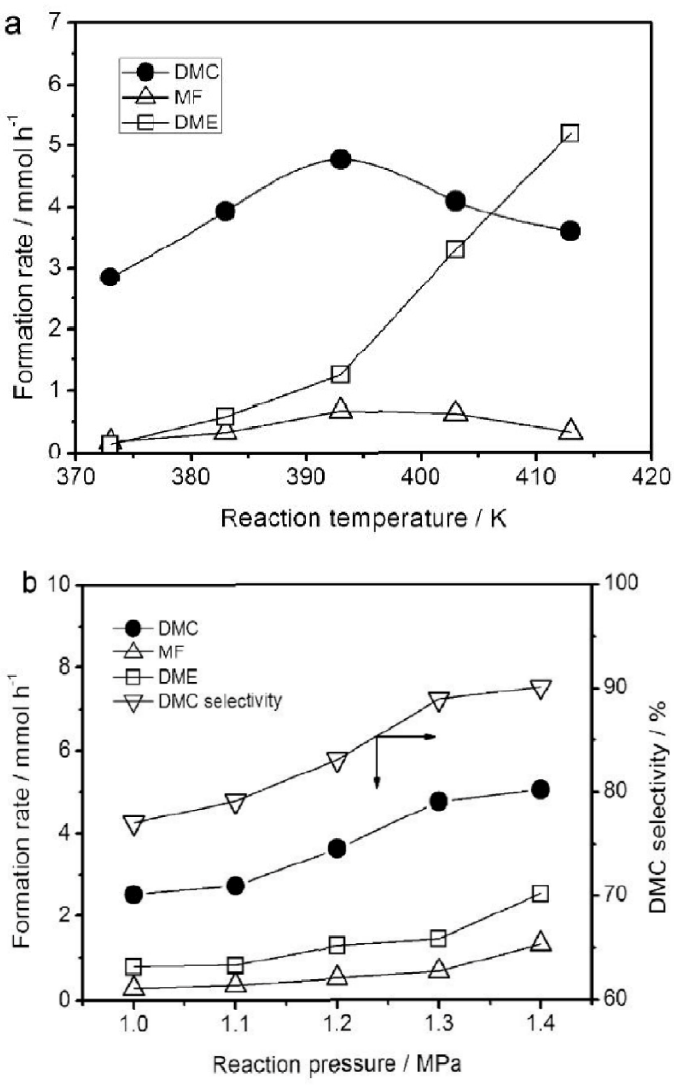
Figure 2. Effects of ( a ) reaction temperature and ( b ) pressure (at 393 K) on the DMC formation from CO 2 and methanol with a CuCl 2 /AC catalyst [42]. (Adapted with permission from Ref. [42], 2010, Elsevier).